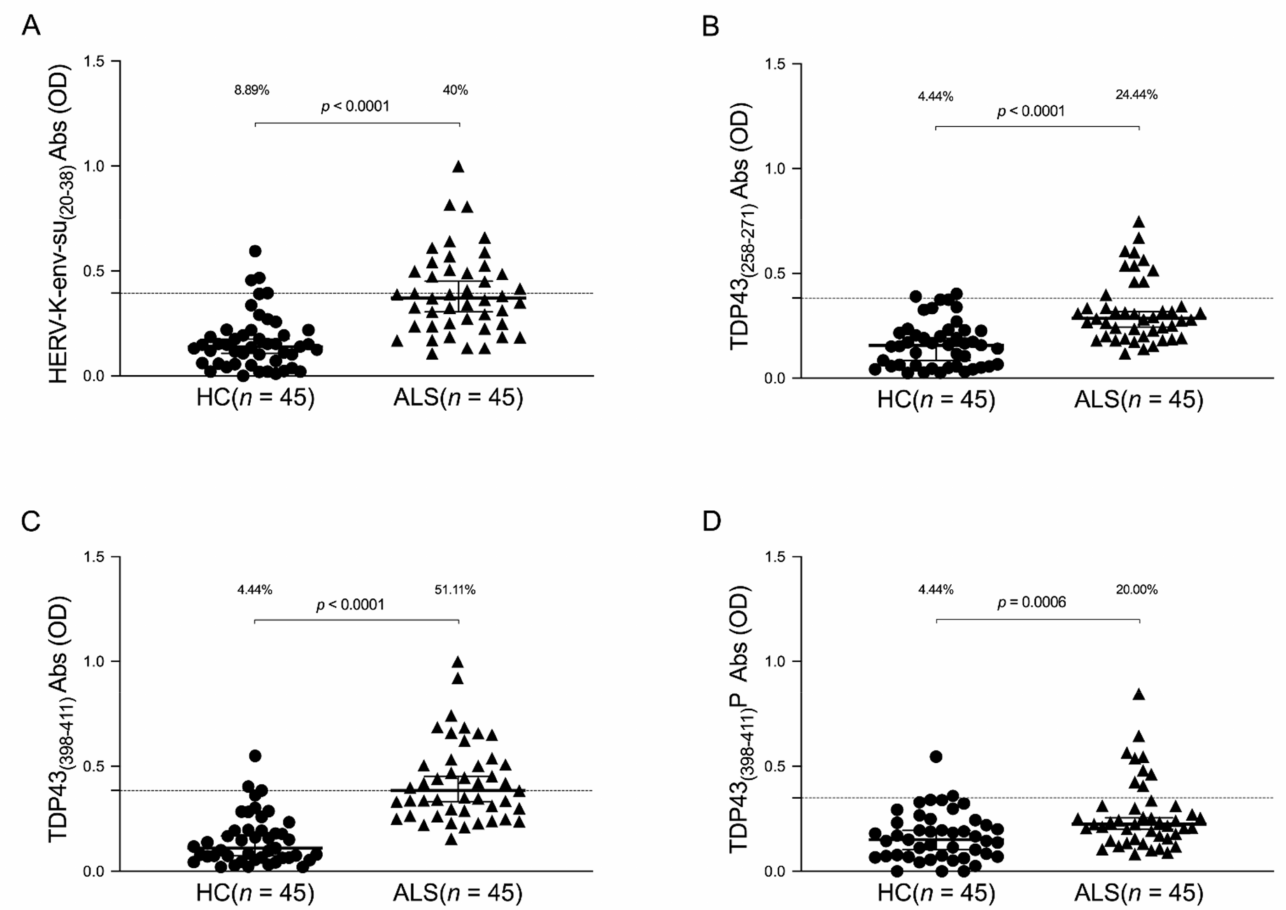
Figure 1. ELISA-based analysis of Abs reactivity against HERV-K- and TDP-43-derived peptides. Plasma samples from ALS patients and HCs subjects were tested against HERV-K-env-su (20–38) ( A ), TDP-43 (258–271) ( B ), TDP-43 (398–411) ( C ), and TDP-43 (398–411) P ( D ) peptides. Median and dashed lines represent thresholds used to assess the samples’ positivity. The Mann–Whitney p- value and the percentage of positive patients evaluated by Fisher’s exact test are indicated in the upper part of each